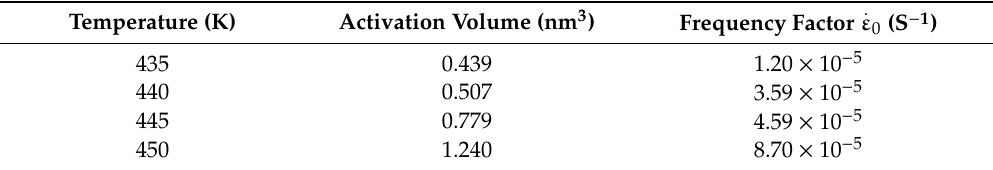
Figure 6. Correlation between the flow stress and strain rate of La 30 Ce 30 Al 15 Co 25 metallic glass at different temperatures. The solid line is the fitting curve. Table 1. The activation volume and frequency factor ε(cid:4662) (cid:2868) of La 30 Ce 30 Al 15 Co 25 metallic glass at different temperatures are calculated from experimental data.